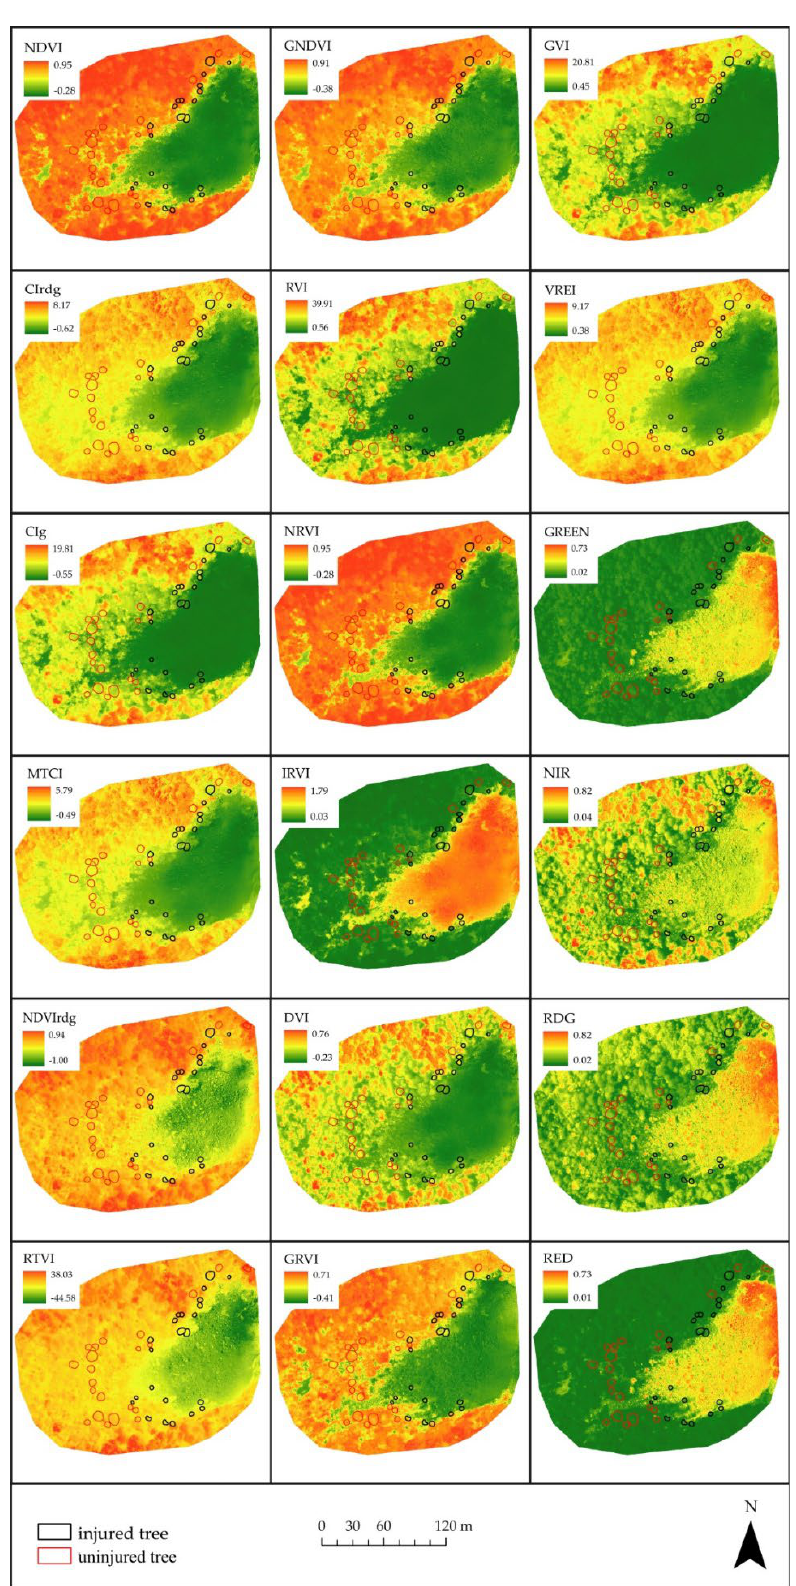
Figure A4. The maps of all vegetation indices (VIs) and individual spectral bands for the Cerkev site (15 August 2019).